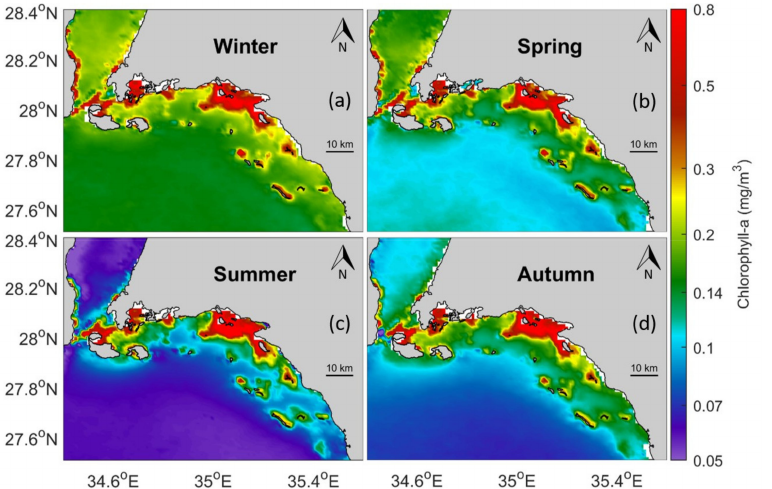
Figure 2. Seasonal climatological maps (21 years) of satellite-derived Chlorophyll-a (mg/m 3 ) over the NEOM region in the Northern Red Sea during: ( a ) Winter: mid-December to mid-March, ( b ) Spring: mid-March to mid-May, ( c ) Summer: mid-May to mid-September, ( d ) Autumn: mid-September to